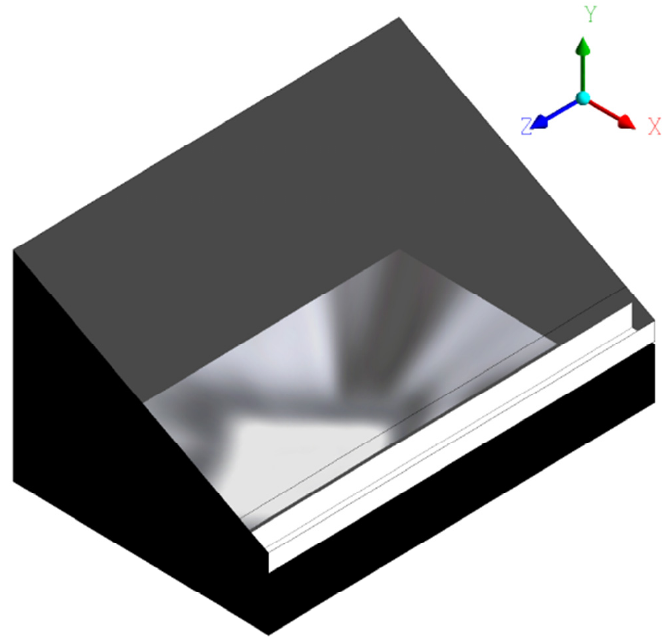
Figure 13. New horizontal geometry model.